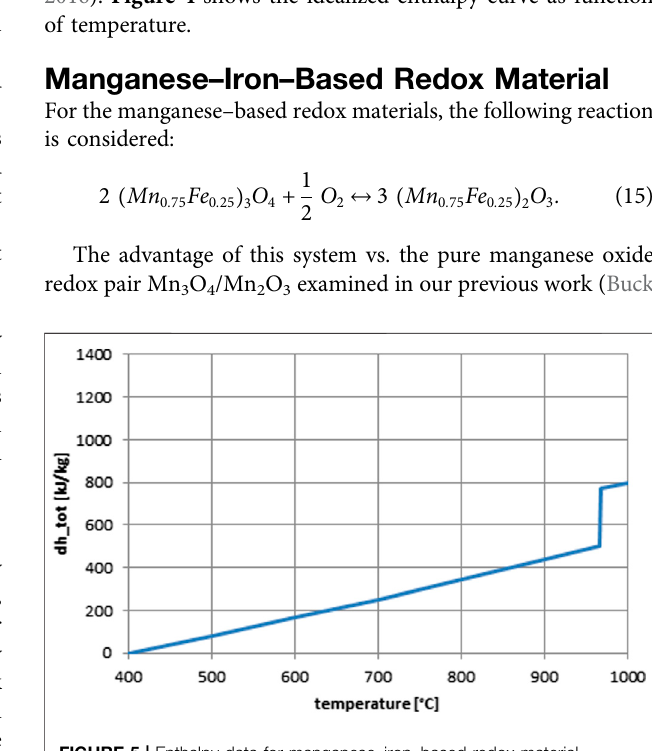
FIGURE 5 | Enthalpy data for manganese – iron – based redox